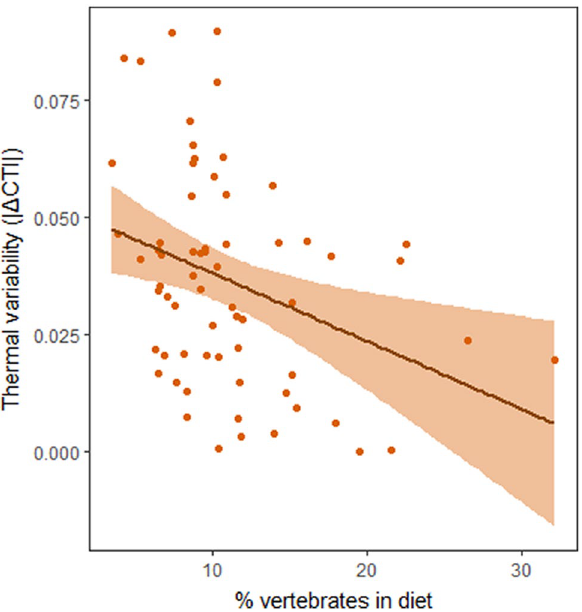
Figure 4. Raw diversity-thermal variability relationship of the best-ranked model in non-breeding season. Figure illustrates the raw linear relationship of the temporal change in community temperature index (|∆CTI|; thermal variability) as a function of the community-weighted mean of percentage of vertebrates in diet in the non-breeding season communities. The best-ranked diversity-thermal variability model for the breeding season communities was the null model that is not illustrated here. Grey icon indicates the season. Note that the effect of temperature trend or the spatial correlation structure are not accounted for in the model structure of the illustrated relationship (for full model statistics, see Appendix S1: Table S3). Figure was produced using R software (Version 3.5.3. URL: http:// www.r- proje ct.